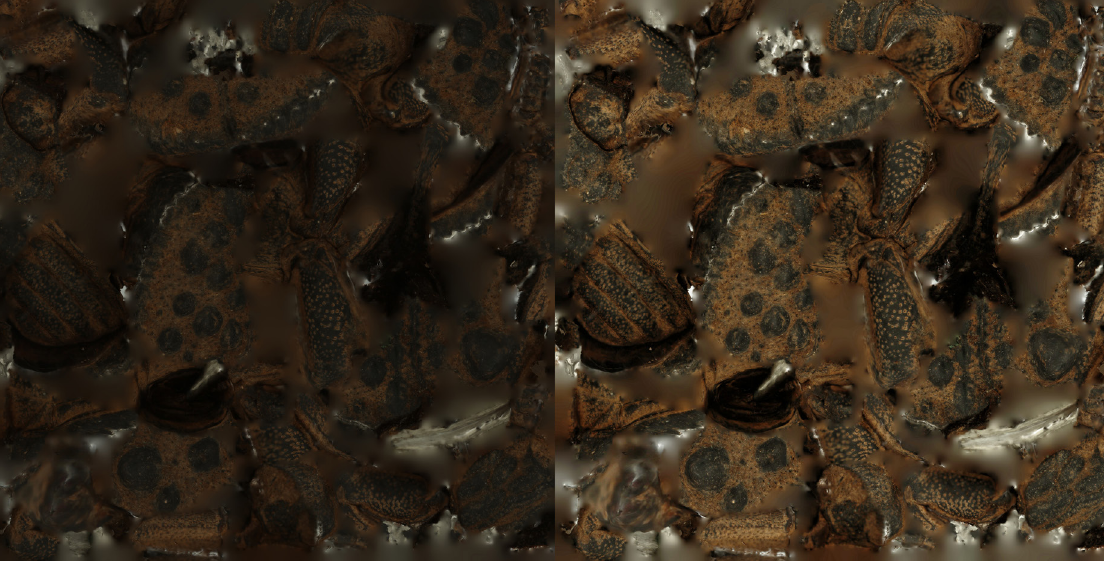
Fig. 5.5. Corrected light settings (right image) for a too-dark texture (left